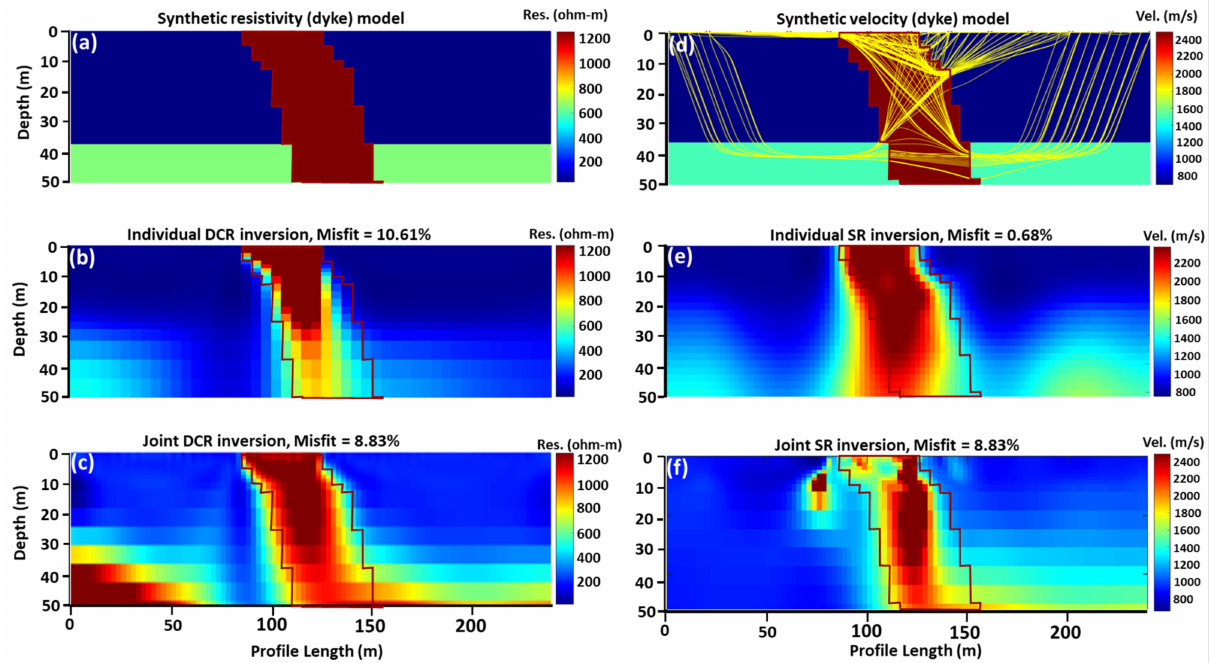
Figure 5. Dyke anomaly model inversion using local optimization method; ( a ) synthetic dc-resistivity model, ( b ) individual inverted resistivity model, ( c ) joint inverted resistivity model, ( d ) synthetic velocity model and its ray path coverage, ( e ) individual inverted velocity model, ( f ) joint inverted velocity model. The dark red line is used to mark the anomaly boundary.